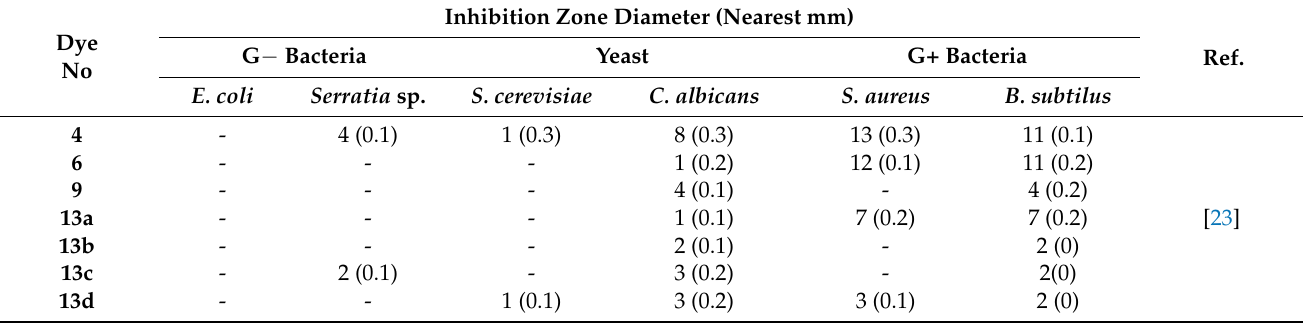
Table 7. Inhibition zonesof compounds 6 , 9 and 13 .